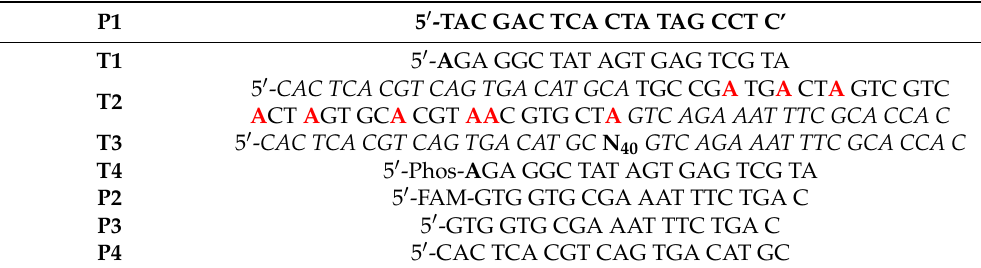
Table 1. DNA primer and templates used for primer extension reactions and PCR to evaluate the compatibility of dU Van TP with enzymatic DNA synthesis a . a italicized letters represent primer binding sites and bold, red letters indicate sites where modified nucleotides can be incorporated. N40 represents the randomized region of the degenerate library.